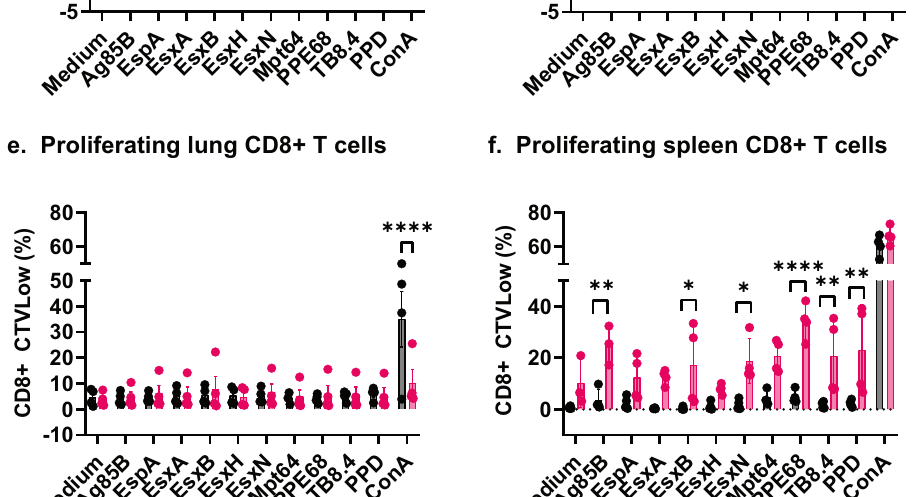
BALB/c mice. In both mouse models, immunizing with rLm5Ag or rLm9Ag induces elevated frequencies of lung and/or splenic CD8 + T cells, consistent with Lm ’ s reputation as a potent inducer of CD8 + T cells 24 . Similarly, in guinea pigs, rLm9Ag induces proliferating antigen-speci fi c CD4 + and CD8 + T cells. CD8 + T cells appear to play a more important role in protection